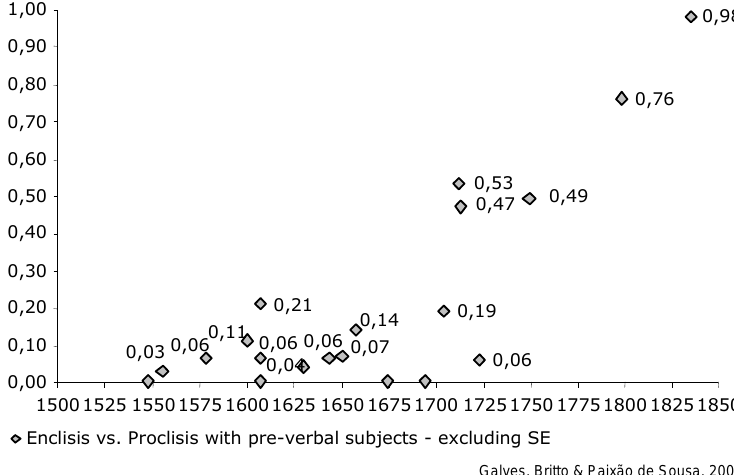
15001525 1550157516001625 165016751700 172517501775180018251850 Enclisis vs. Proclisis with pre-verbal subjects - excluding SE Galves, Britto & Paixão de Sousa,